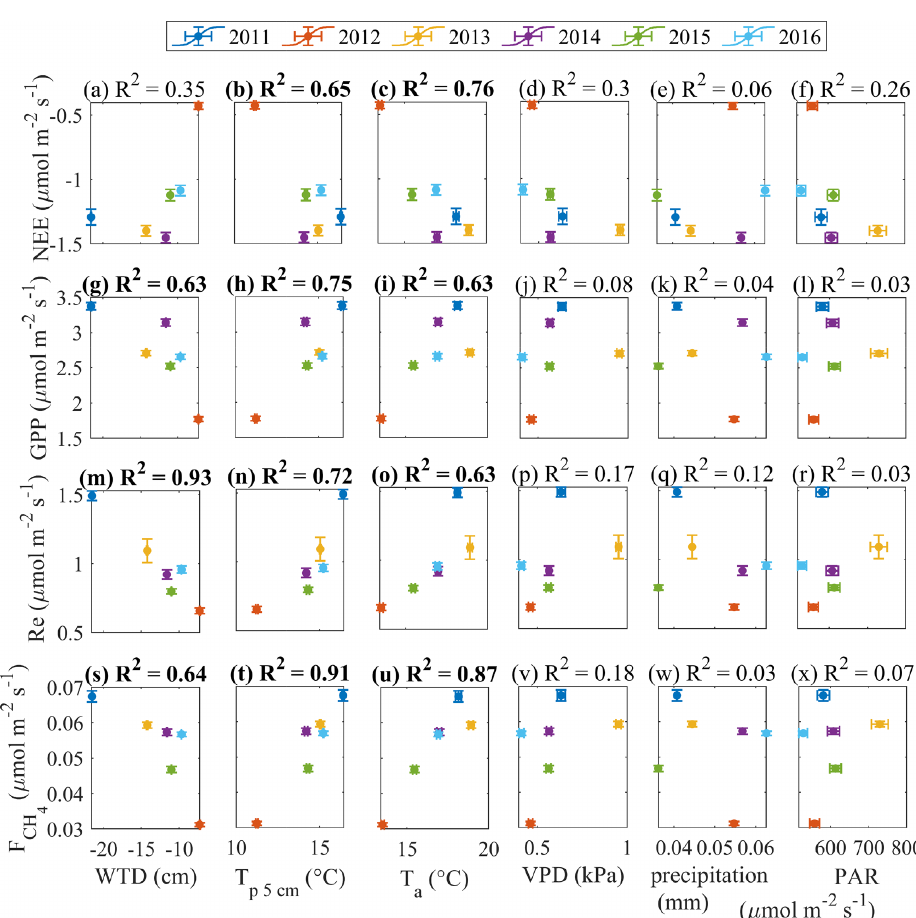
Figure 11. May–September mean gap-filled fluxes versus averages (or cumulative, in the case of precipitation) of environmental drivers.